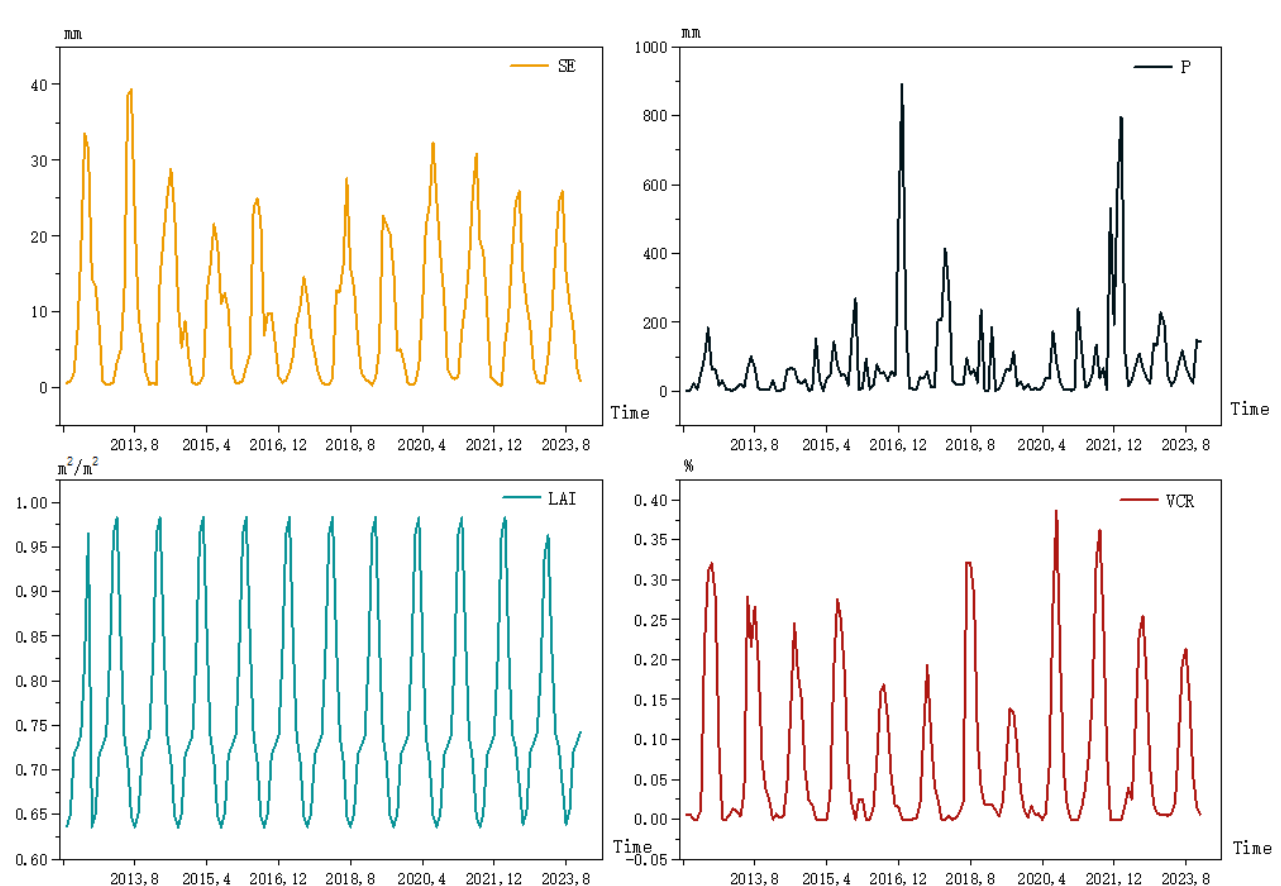
Figure 4. Historical data of the SE, P and LAI and the fitted VCR data. Table 5. Prediction data for SE, P, LAI and VCR, and the fitted values of IC store and ∆ β